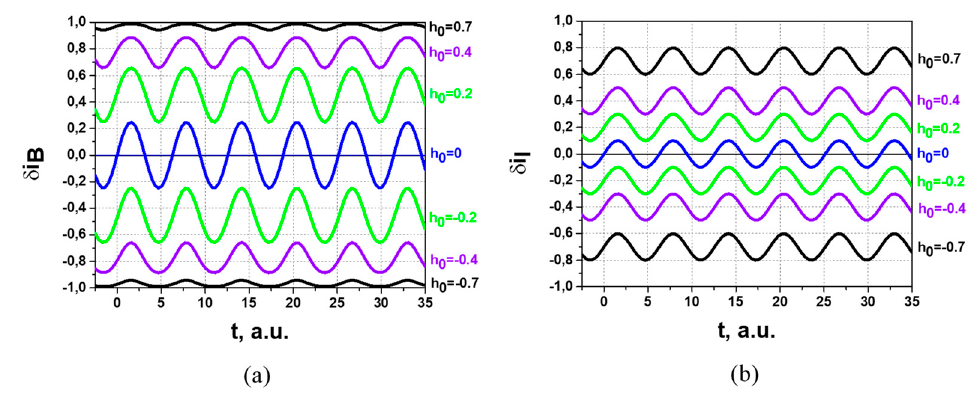
Figure 10. δ i response on harmonic variation of beam position on SPD for different h 0 for bell-shape ( a ) and ideal uniform ( b ) beam.